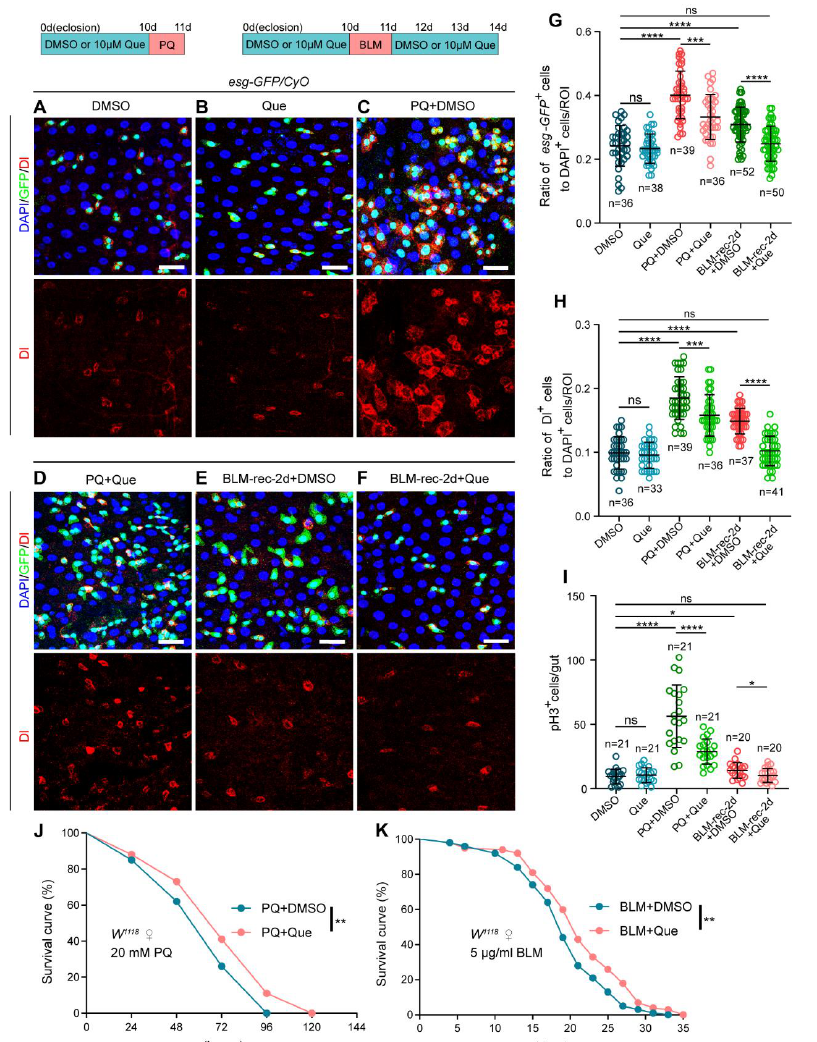
Figure 2. Que prevents stimulus-induced hyperproliferation of ISCs and improves stress tolerance in Drosophila . ( A – F ) Representative immunofluorescence images of Drosophila posterior midguts stained with DAPI, GFP, and Dl for DMSO ( A ), Que ( B ), PQ + DMSO ( C ), PQ + Que ( D ), BLM-rec-2d + DMSO ( E ), and BLM-rec-2d + Que ( F ) groups. The 0-day-old flies were fed with 10 µ M Que for 10 days, then treated with 10 mM PQ for 1 day, followed by dissection. The 0-day-old flies were fed with 10 µ M Que for 10 days, then treated with 25 µ g/mL BLM for 1 day, and then resumed feeding with 10 µ m Que for 1/2/3 days, followed by dissection. The top panels represent the merged images, whereas the bottom panels represent Dl. Scale bars represent 25 µ m. ( G , H ) The ratio of esg-GFP + cells ( G ) and Dl + cells ( H ) to DAPI + cells per ROI in the posterior midguts of flies in experiments ( A – F ). n: number of ROI counted. ( I ) The number of pH3 + cells in the whole gut of flies in experiments ( A – F ). n: number of gut counted. ( J , K ) Survival percentage of female W 1118 flies with DMSO (blue curve) or Que (pink curve) supplementation under 20 mM PQ (J) or 5 µ g/mL BLM ( K ) treatments. Each group had 100 flies and three independent experiments were conducted. Error bars represent SDs. Log-rank test was used for lifespan analysis. Student’s t -tests, * p < 0.05, ** p < 0.01, *** p < 0.001, **** p < 0.0001, and non-significance (ns) represents p >